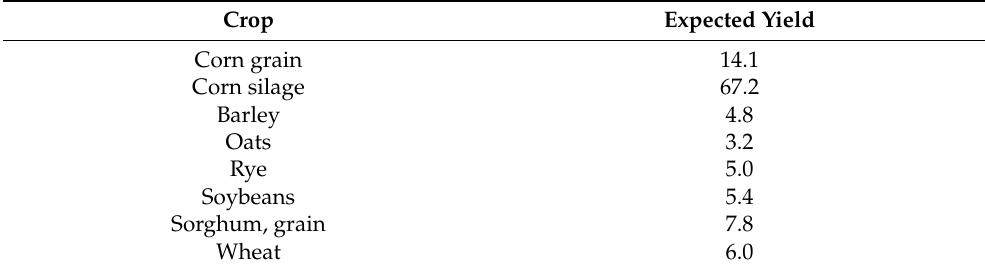
Table 3. Expected grain crop yields (MT · ha − 1 ) on more productive soils over a three to five year period, under best management practices based on surveys conducted in 2020 of West Virginia farmers and regional variety trails.